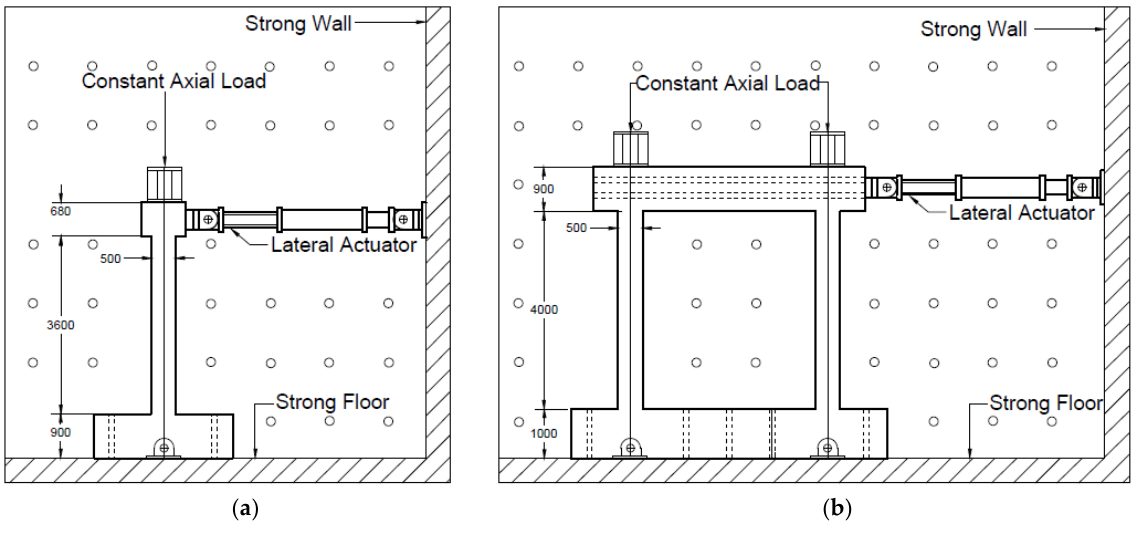
Figure 3. Test setup: ( a ) NEWRC columns; ( b ) NEWRCF. Unit: mm.